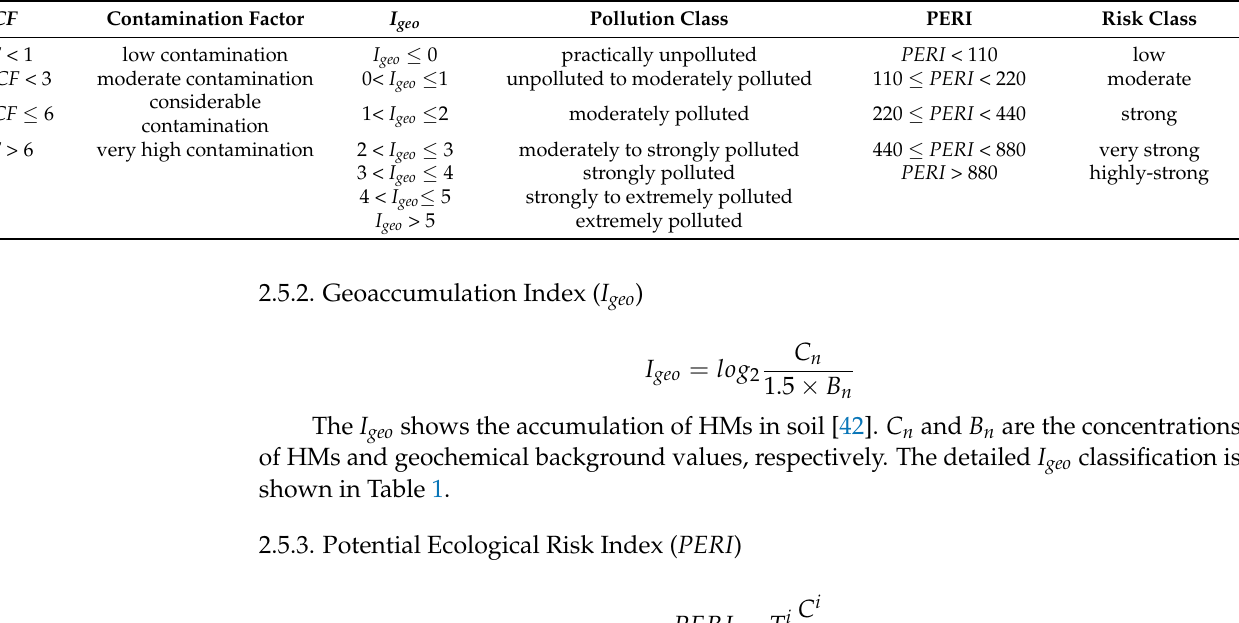
Table 1. Grading criteria for contamination factor (CF), geoaccumulation ( I geo ), and potential ecologi- cal risk index ( PERI